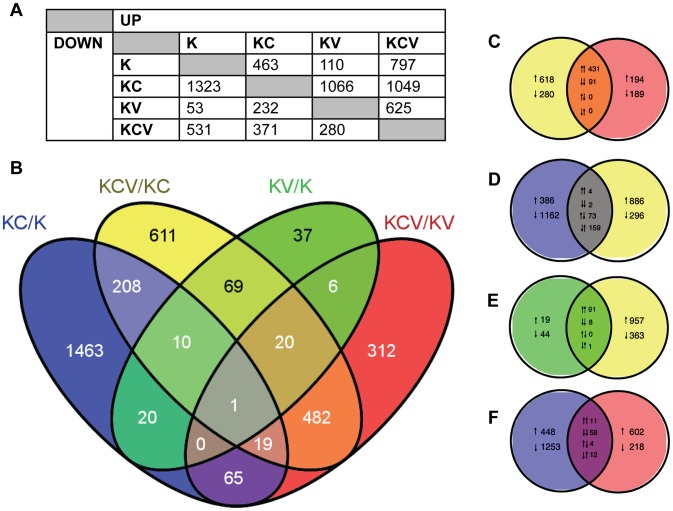
Overview of transcription data.
A) Summary of the number of significantly up and down regulated genes (FDR<0.01) observed across all six possible comparisons of the four sample types e.g. 463 genes are up regulated in KC/K whilst 53 genes are down regulated in KV/K. B) Venn diagram indicating the number of significant (FDR<0.01) differentially expressed genes across four key comparisons (KCV/KC, KC/K, KV/K and KCV/KC) and the overlap between each set of genes. C–F) Detailed analysis between the four comparisons illustrating the overlap between up and down regulated gene lists. Pairs of arrows in the intersection refer to the direction of fold change in the comparisons on the left and right hand sides respectively. Comparisons are shown for: C) KCV/KV and KCV/KV, D) KC/K and KCV/KC, E) KV/K and KCV/KC and F) KC/K and KCV/KV genes. For these four Venn diagrams (e.g comparison X vs. comparison Y), those genes that are up or down-regulated in X but not significantly altered in Y are shown on the left-hand side with single arrows denoting the direction of fold change. The converse is shown on the right-hand side (i.e. genes that are differentially expressed in Y but not in X), again with up or down arrows denoting the direction of fold change. The overlaps themselves show the 4 possible options: up in both X and Y, down in both X and Y, up in X and down in Y, or down in X and up in Y. These are denoted by pairs of arrows, with the left-hand arrow referring to the direction of fold change in X and the right-hand arrow denoting the direction of fold change in Y e.g. in KC/K vs. KCV/KC (D), 4 genes are up regulated in both comparisons, 2 are down regulated in both comparisons, 73 are up regulated in KC/K but down regulated in KCV/KC whilst 159 are down regulated in KC/K but up regulated in KCV/KC.